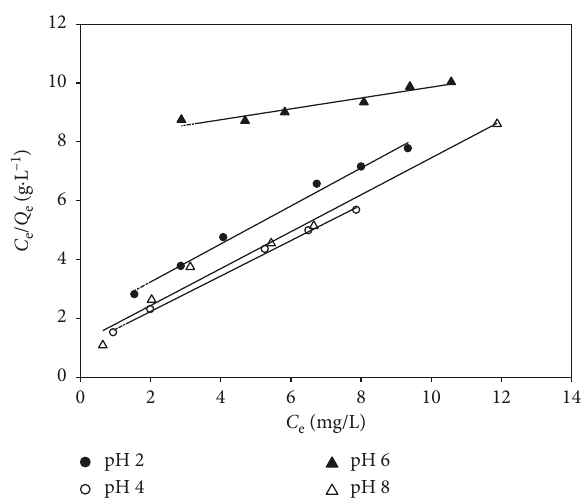
Figure 9: Langmuir plots for Cr(VI) biosorption by Grewia spp. biopolymer. Contact time 60min, T